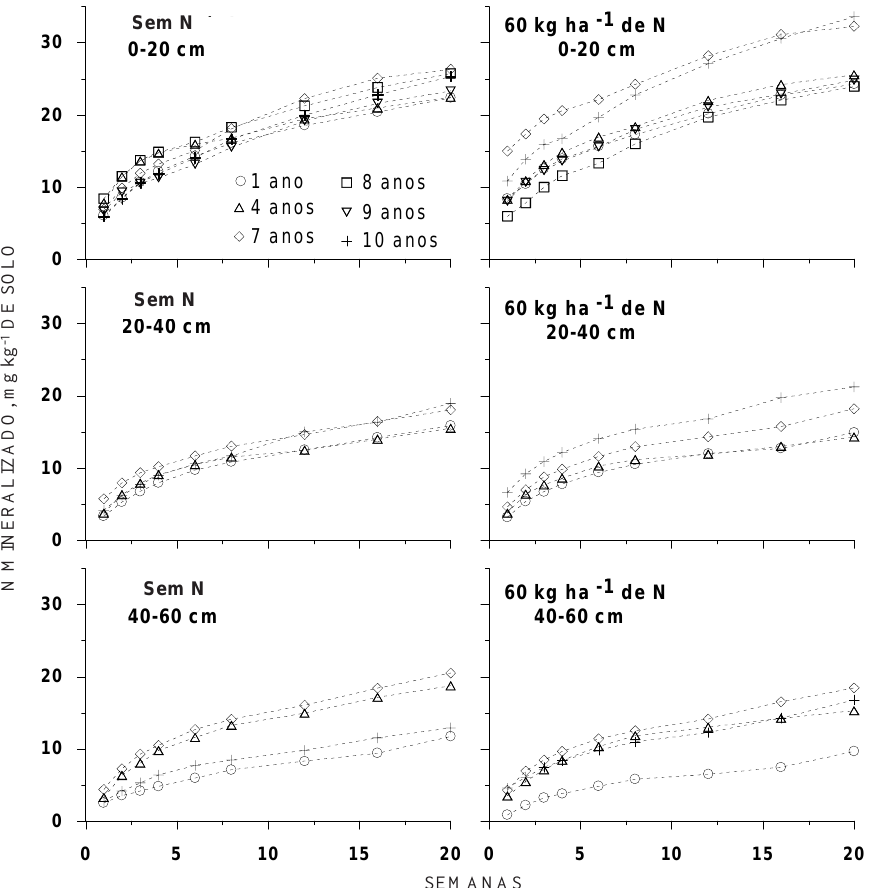
Figura 1. Mineralização acumulada de N-(NH 4+ + NO 3- ) em 20 semanas de incubação, em amostras retiradas das profundidades de 0-20, 20-40 e 40-60 cm de um solo PVA, em diferentes épocas após o início do cultivo com cana-de-açúcar, sem N e com 60 kg ha -1 de N.